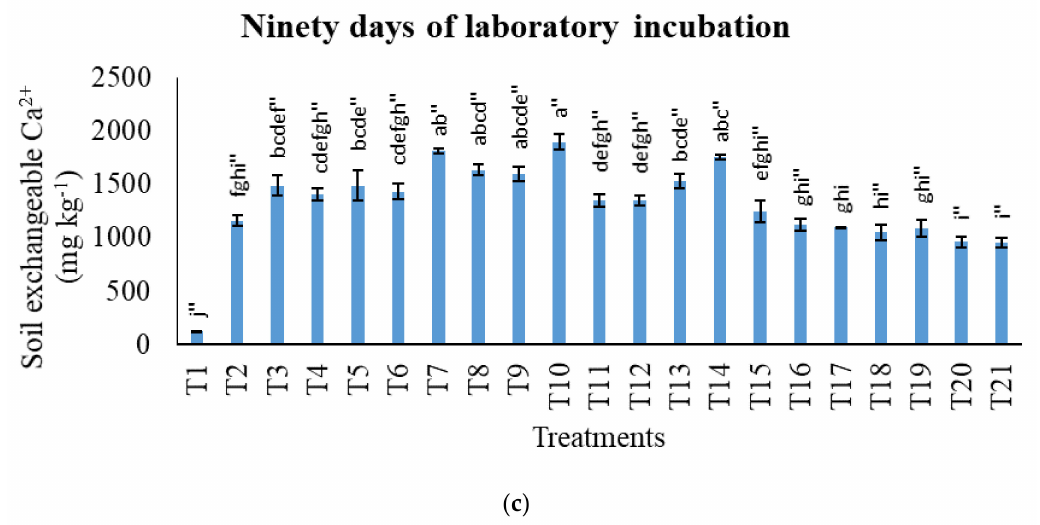
Figure 7. Effects of treatments on soil-exchangeable calcium over ( a ) thirty; ( b ) sixty; and ( c ) ninety days after incubation.